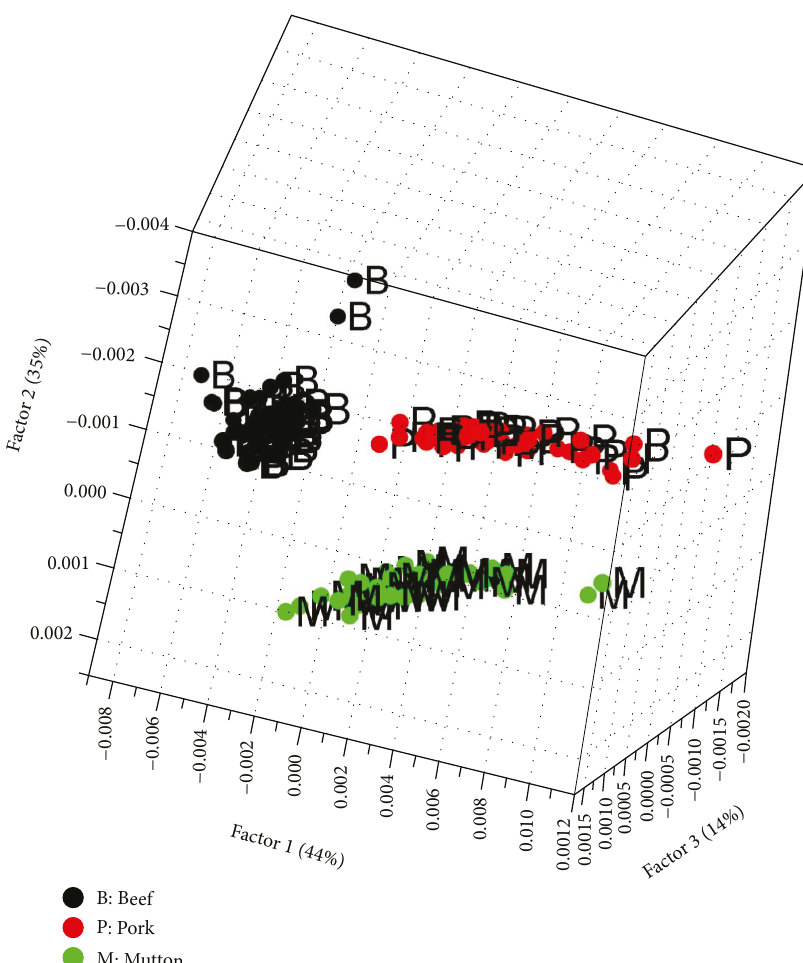
Figure 5: Visualization of sample densities in 3d data of the meat samples represented black, red, and green dots for B (beef), P (pork), and M (mutton),